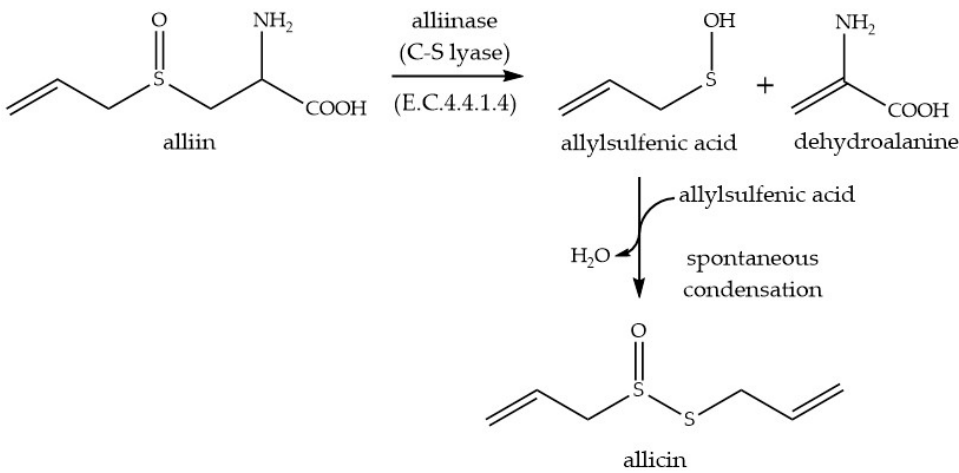
Scheme 1. Enzyme-catalyzed biosynthesis of